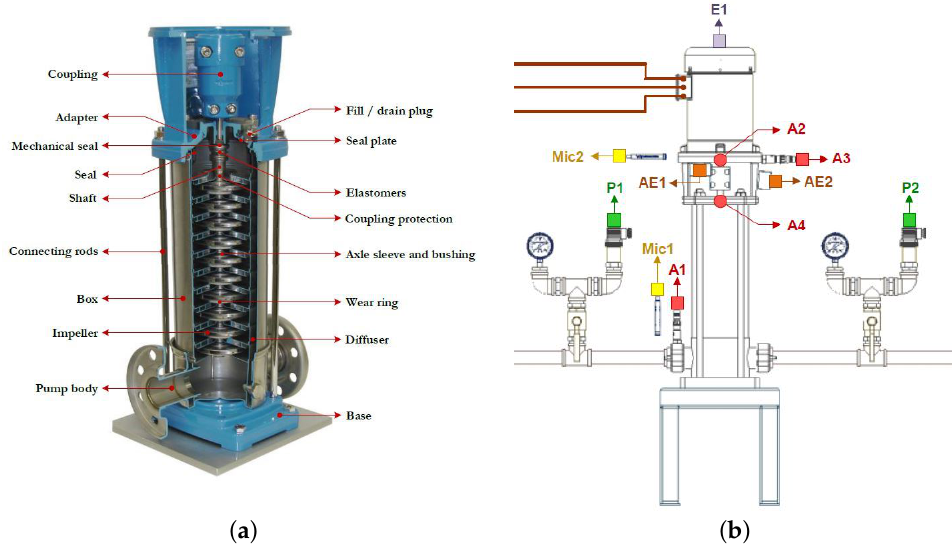
Figure 1. CP and sensors. ( a ) Multi-stage vertical CP. ( b ) Locations of sensors. The vibration signals were recorded using A1, A2, A3, and A4 accelerometers.